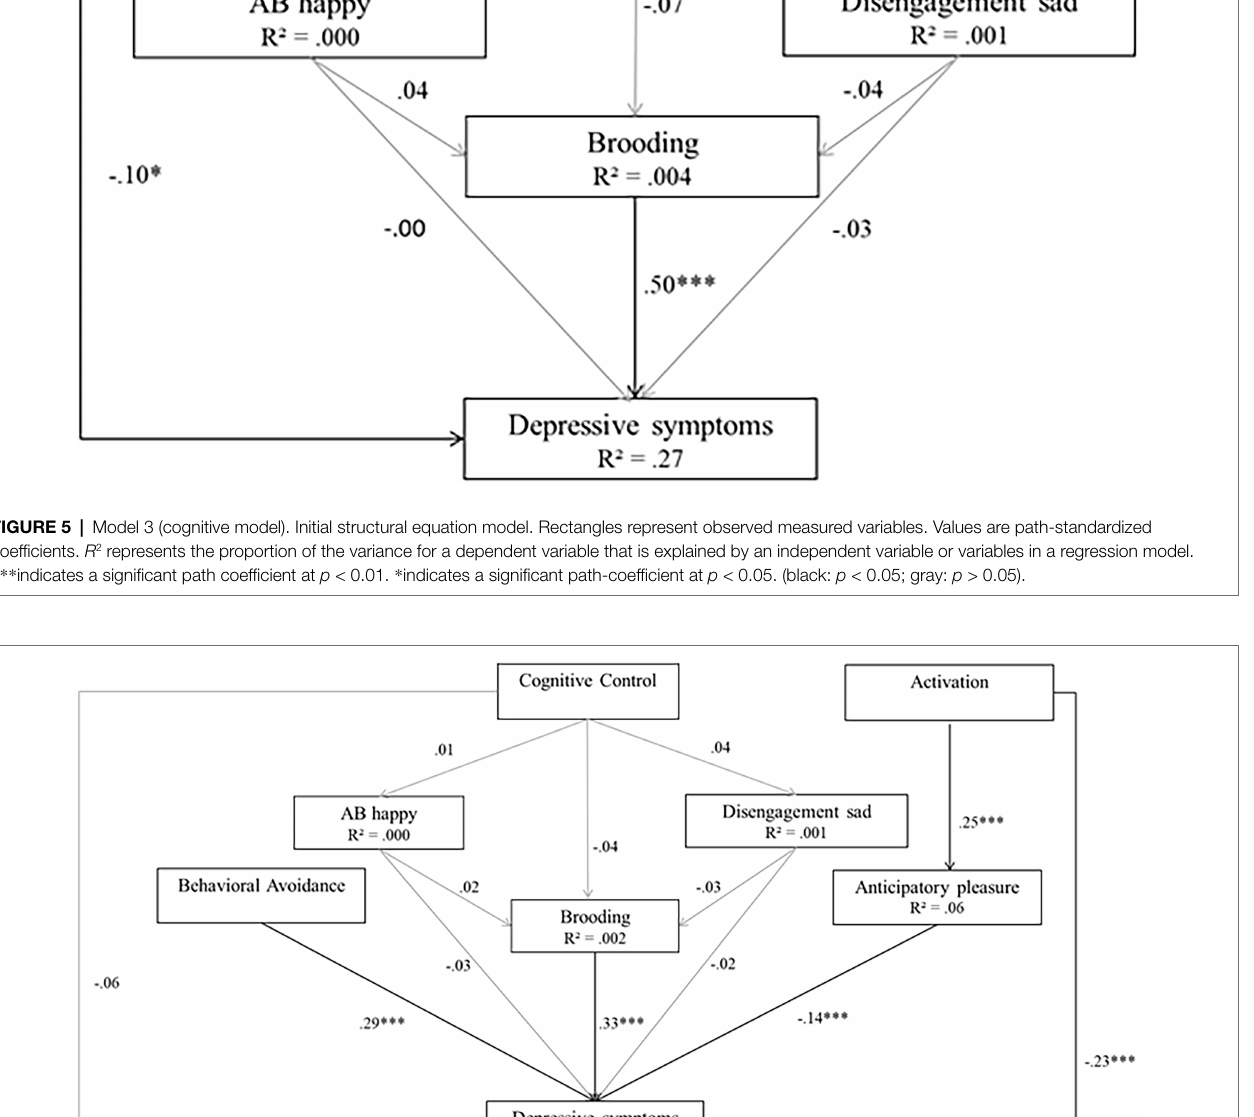
predictor after controlling for the effects of the other predictors.